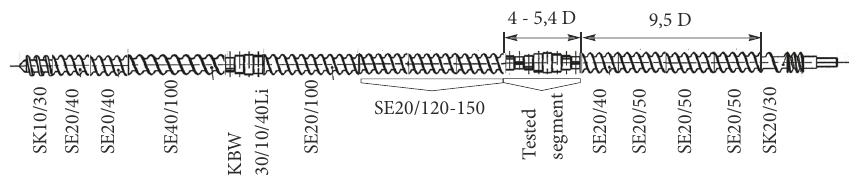
Figure 2: Configuration of the screws. SK represents single-flight transporting segments; SE represents double-flight transporting segments. The first number is the flight pitch, the second is the length of a segment, and KBW represents the kneading segments with double-lobe cams (disks). The first number is the angle between the cams’ axes of symmetry, the second one is the width of cam elements, and the third is the length of a segment; the letter denotes the inclination of the apparent screw line of cam elements (Li: left; no letter: right).